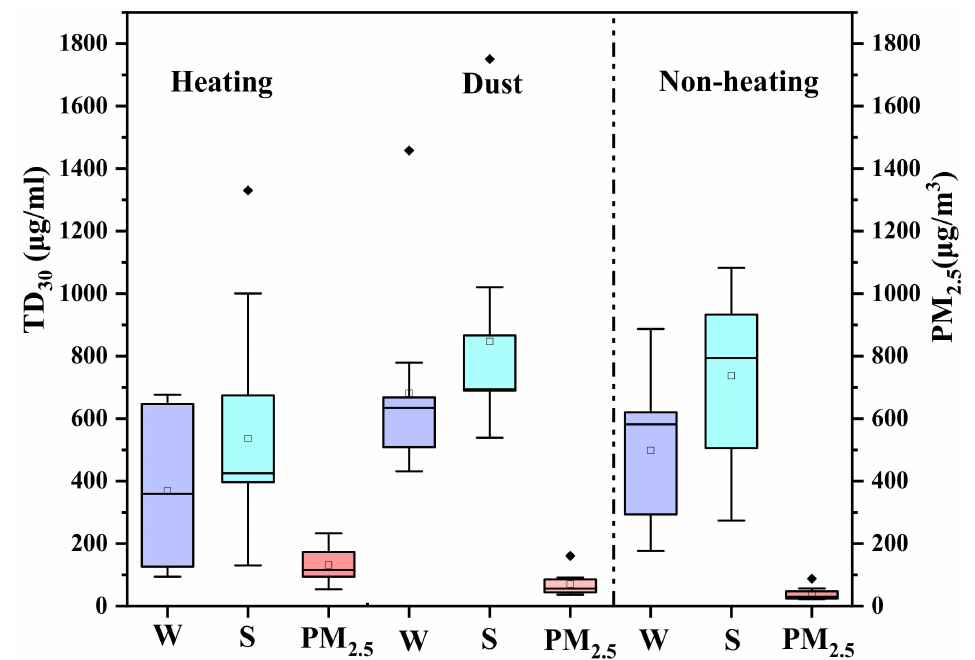
Figure 2. The seasonal distribution of oxidative capacity and PM2.5 mass concentrations. (W: whole samples; S: water-soluble